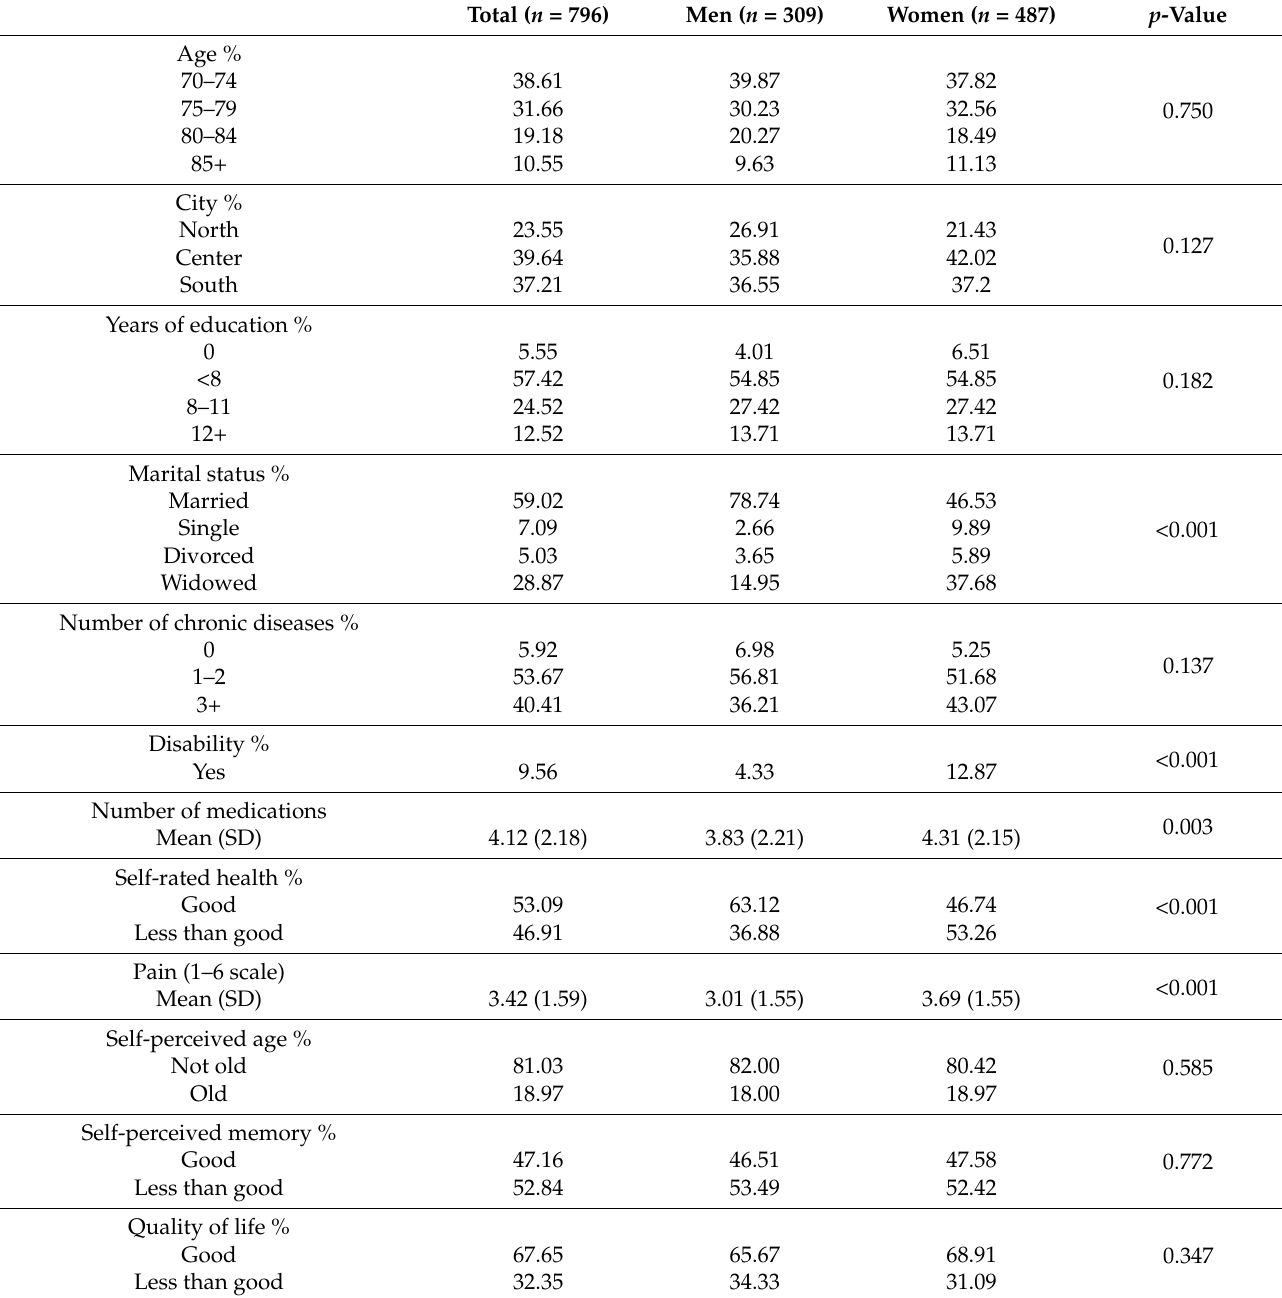
Table 1. Characteristics of the